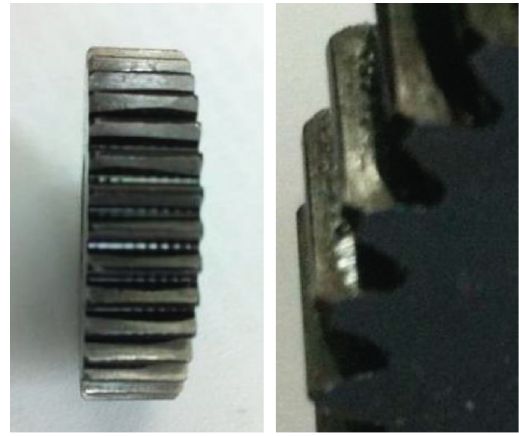
Figure 18: Fixed-axis wear failure